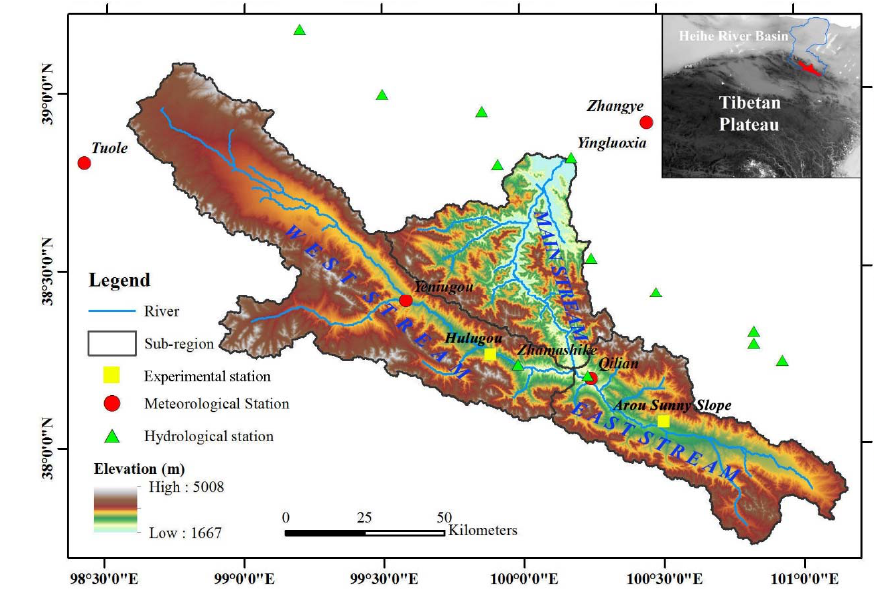
Figure 1. Upper Heihe River Basin.